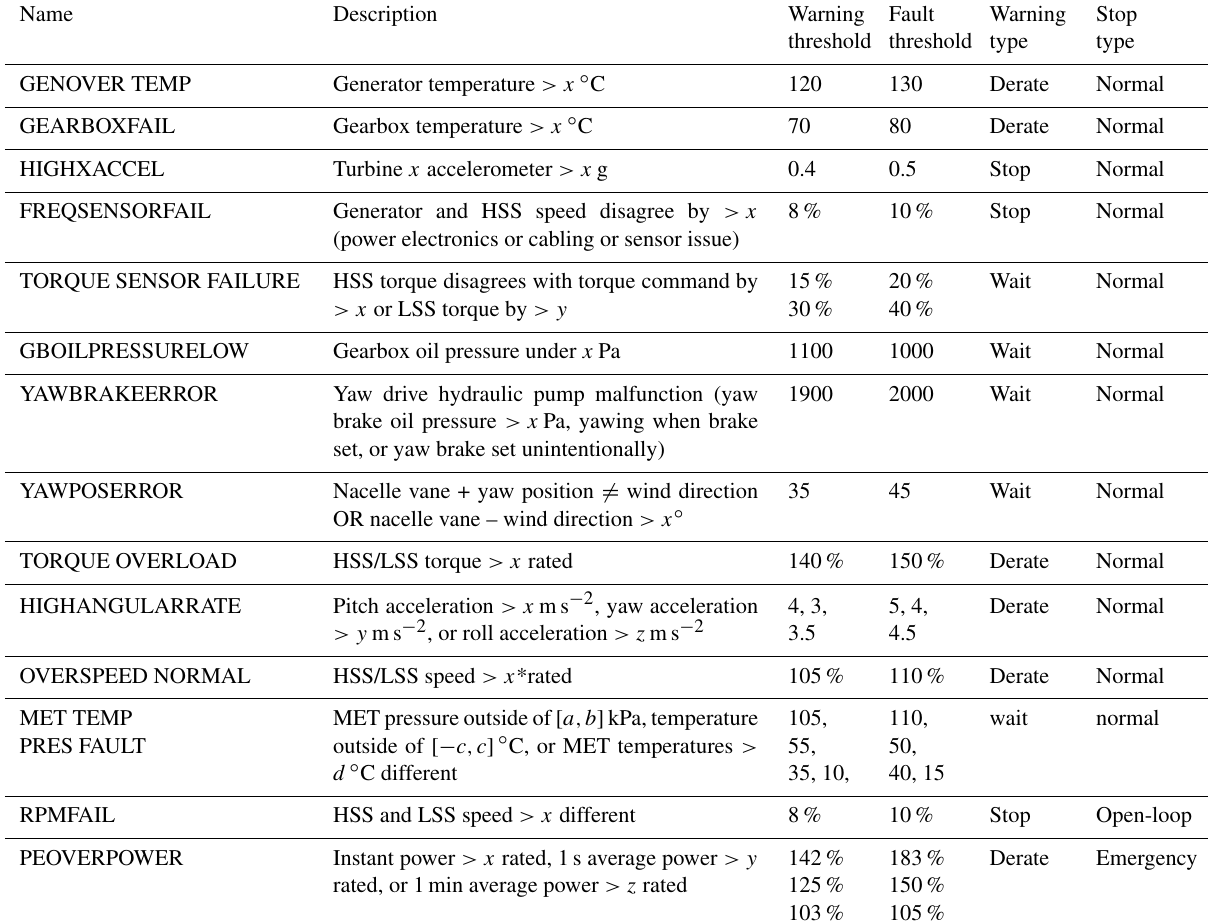
Table A1. Detailed information on quantities checked and their